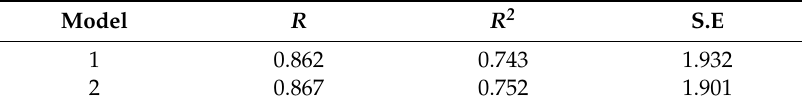
Table 4. Goodness-of-fit results from the two regression